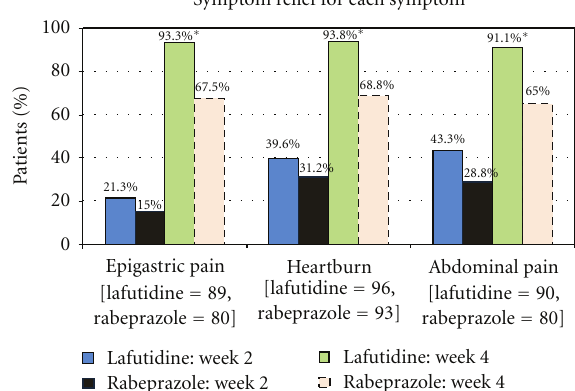
Figure 2: Proportion of patients who reported symptom relief for each individual symptom from baseline. The number of patients listed for each symptom is the number of patients that reported that symptom with a GOS score ≥ 4 at baseline. ∗ P < . 01 between the two treatment groups at week